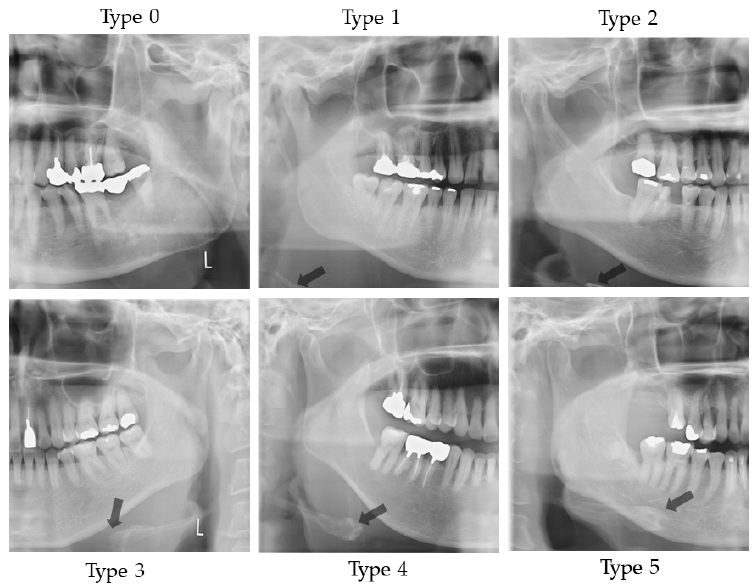
Figure 2. Sample images of vertical hyoid bone position. Arrow shows the hyoid bone. On Type 0, hyoid bone is invisible. hyoid bone is